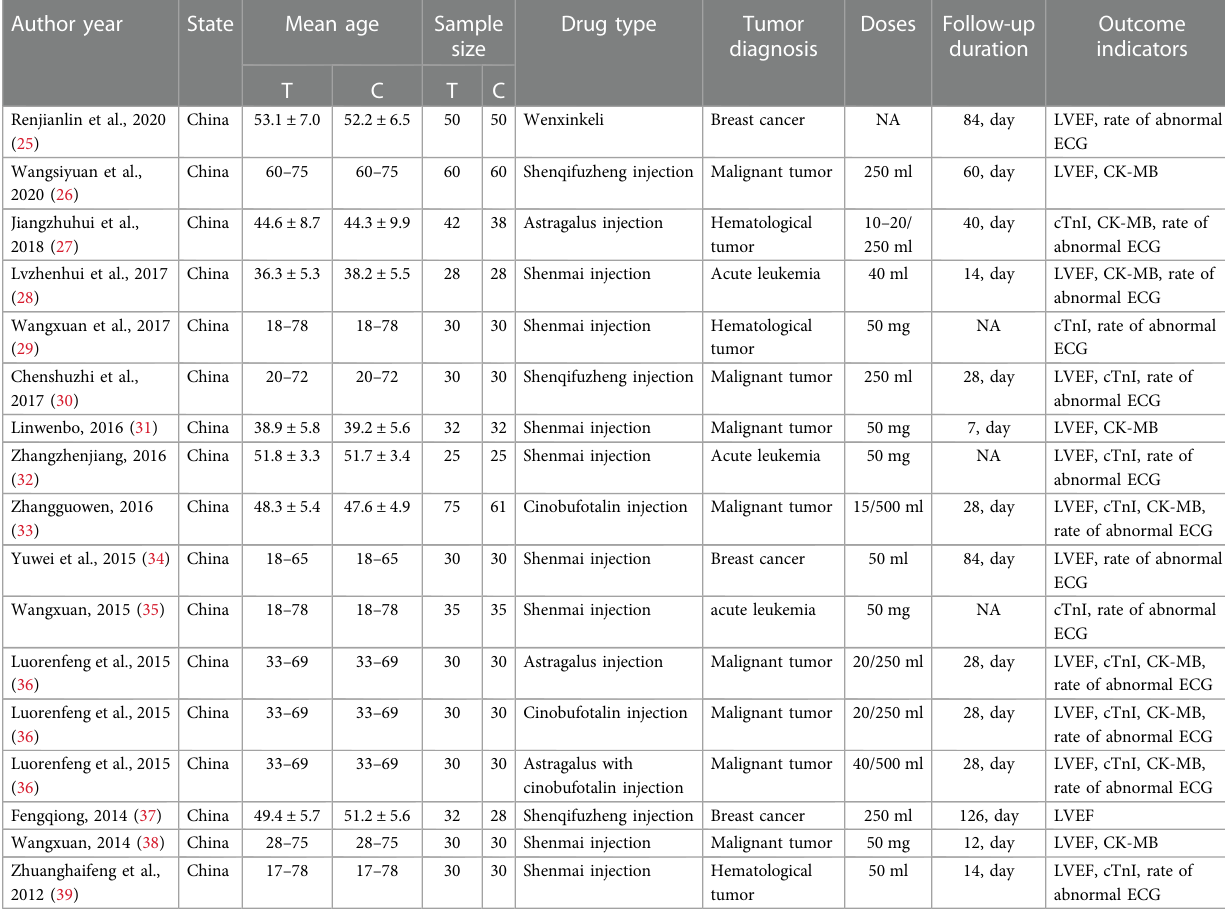
TABLE 1 General characteristics in a network meta-analysis of the therapy of anthracycline-induced cardiotoxicity patients.